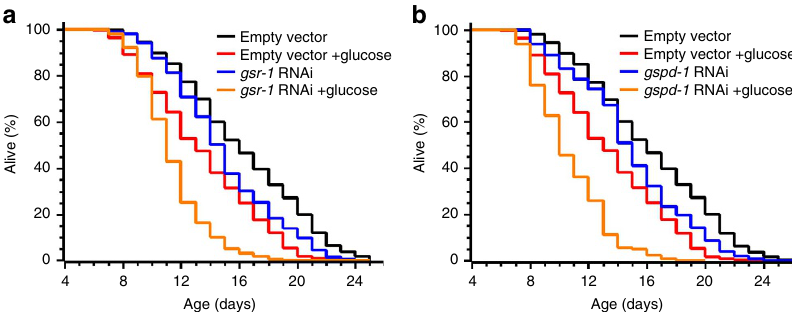
Figure 5 | Blocking the endogenous antioxidant system does not influence glucose-mediated life shortening. ( a and b ) Wt worms grew on NGM plates seeded with E. coli HT115 harbouring either an empty vector (black and red curves) or a plasmid expressing either double-stranded gsr-1 ( a ) or gspd-1 ( b ) RNAi (blue and orange curves). L4 stage animals were transferred to NGM plates without (black and blue curves) or with (red and orange curves) glucose (see also Supplementary Table 2). For RNAi efficiency, see Fig.